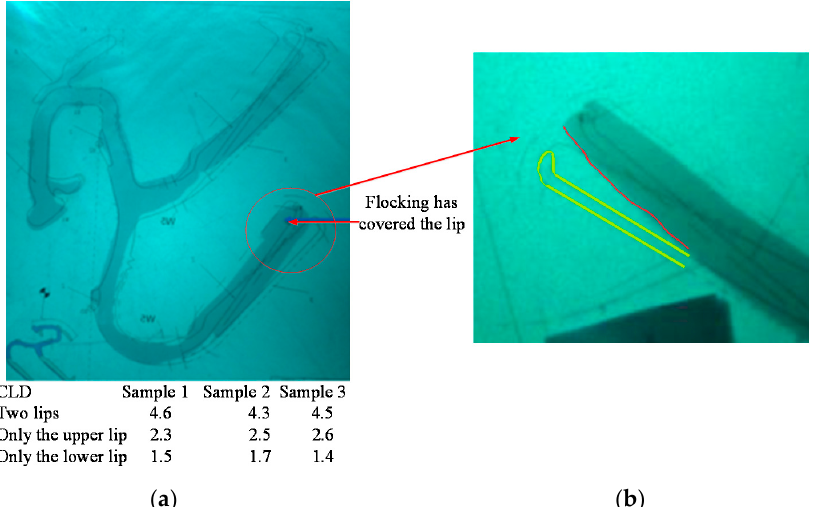
Figure 22. Inner belt test sample in automobile. ( a ) Inner belt sample; ( b ) improved sample of inner belt.